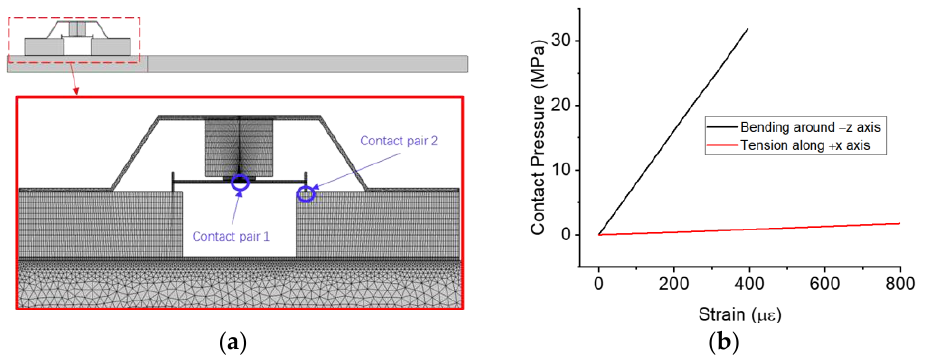
Figure A1. The finite element analysis of a BAW strain sensor. ( a ) Meshes and boundary conditions. ( b ) Comparison between tensile strain and bending strain.